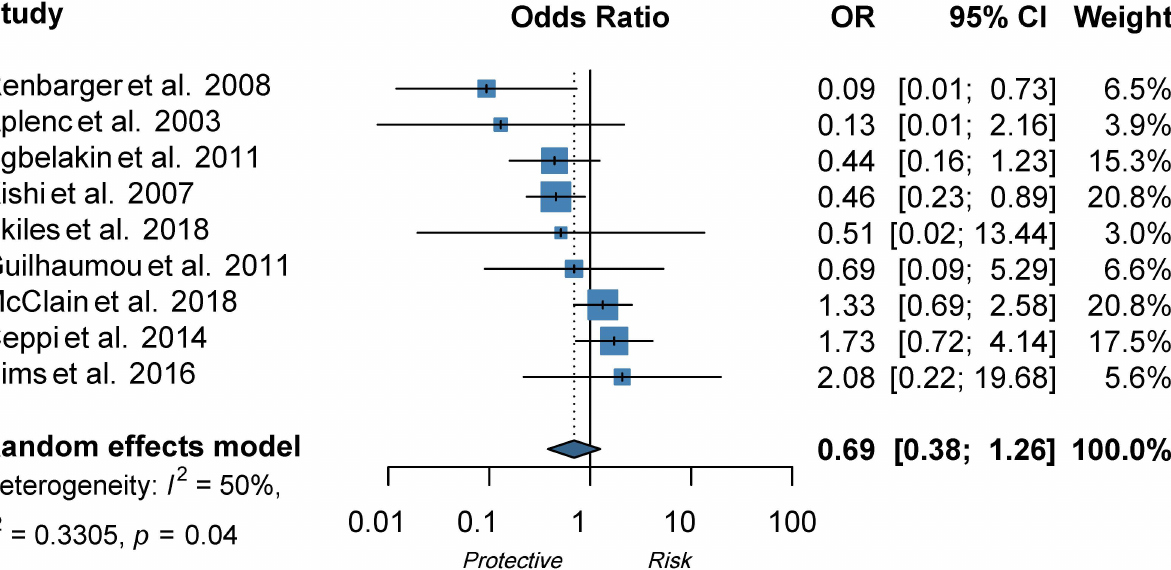
Figure 3. Forest plot showing the effect of CYP3A5 expression status on VIPN, ORs describe the effect of expression of CYP3A5 in comparison to non-expression of CYP3A5 [8,13,14,16,20,28,29,31,32]. The functional allele is *1 and variant alleles are *3 (rs776746), *6 (rs10264272), and *7 (rs41303343). A dominant model was adopted: patients with at least one *1 allele are considered to be expressers of CYP3A5. Patients without *1 allele are considered to be non-expressers of